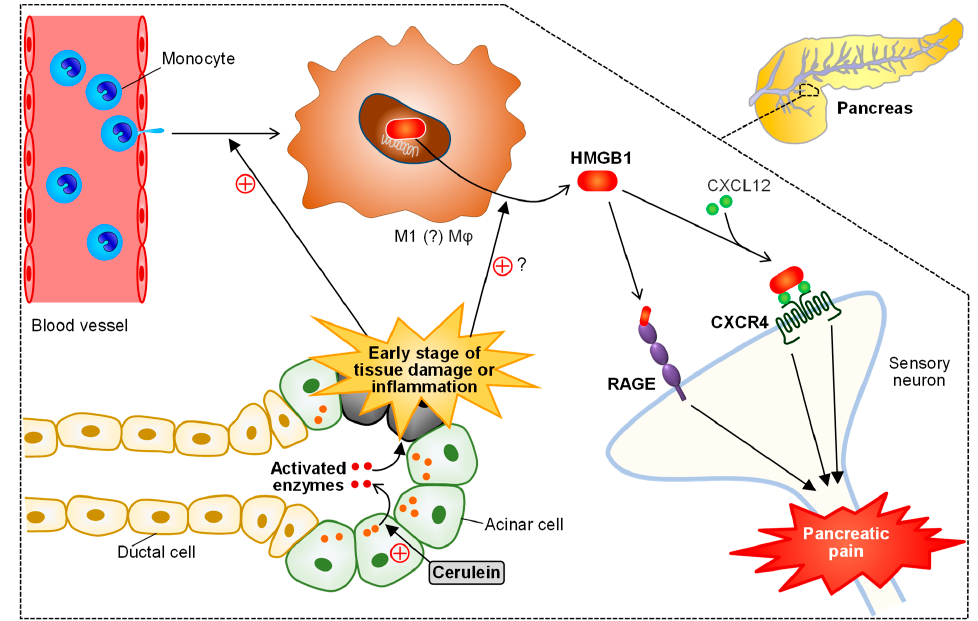
Figure 6. Role of macrophage-derived HMGB1 in the development of pancreatitis-related visceral pain in mice treated with cerulein. In the early stage of cerulein-induced acute pancreatitis, circulating monocyte-derived infiltrating macrophages release HMGB1, which in turn activates the receptor for advanced glycation end-products (RAGE) and accelerates C-X-C motif chemokine ligand (CXCL) 12/C-X-C motif chemokine receptor (CXCR) 4 signals, leading to pancreatic pain.